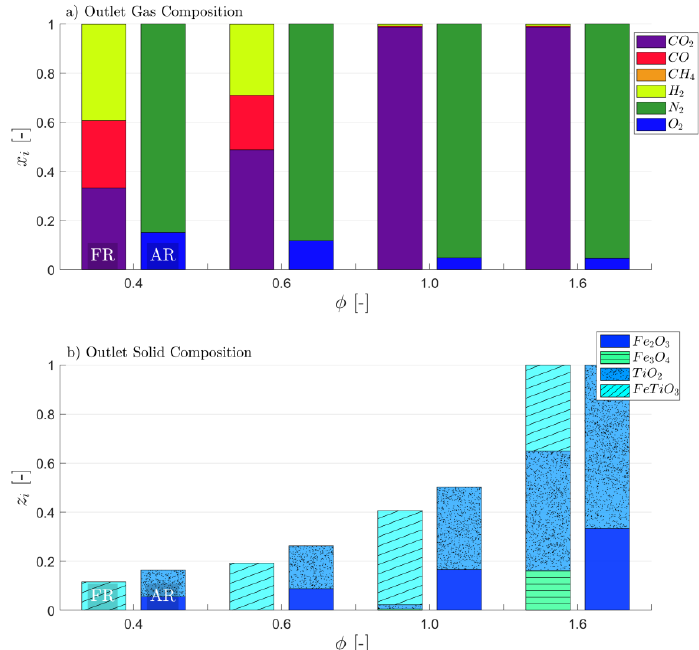
Figure 6. Simulation results for CLG operation through OC dilution with inert SiO 2 sand. Dry molar gas composition ( a ) and molar solid composition ( b ) as a function of 𝜙 for varying OC circulation rates ( 𝜆 = 1.2, 𝑚̇ 𝑂𝐶 + 𝑚̇ 𝑆𝑖𝑂2 = 𝑐𝑜𝑛𝑠𝑡. ).